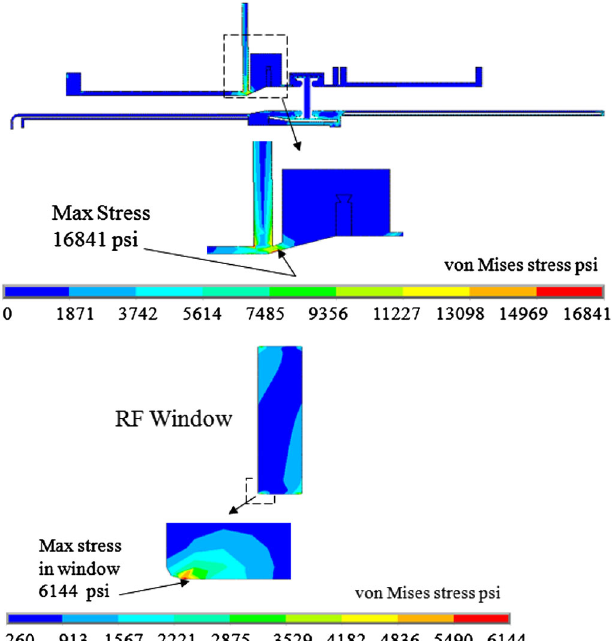
FIG. 5. Von Mises stress contours under 1 MW of rf power.